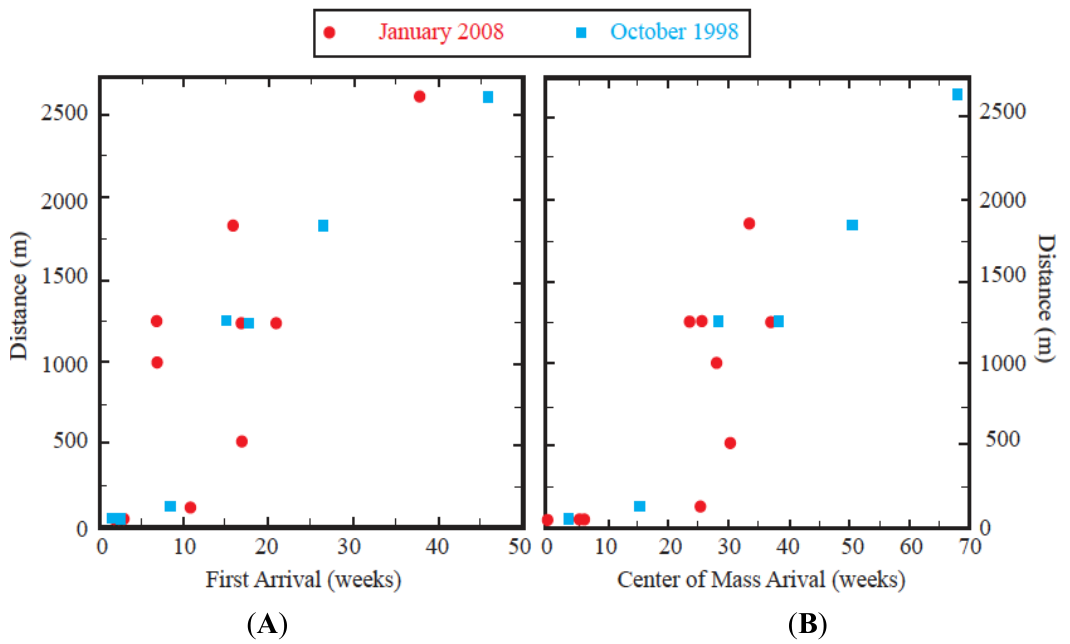
Figure 5. Comparison between the arrival times and distance from the January 2008 and October 1998 tracer experiments. ( A ) First arrival and ( B ) COM. Note the change of scale on the x-axis. During the January 2008 experiment, COM arrivals could not be calculated at all wells because of incomplete breakthroughs (see Table